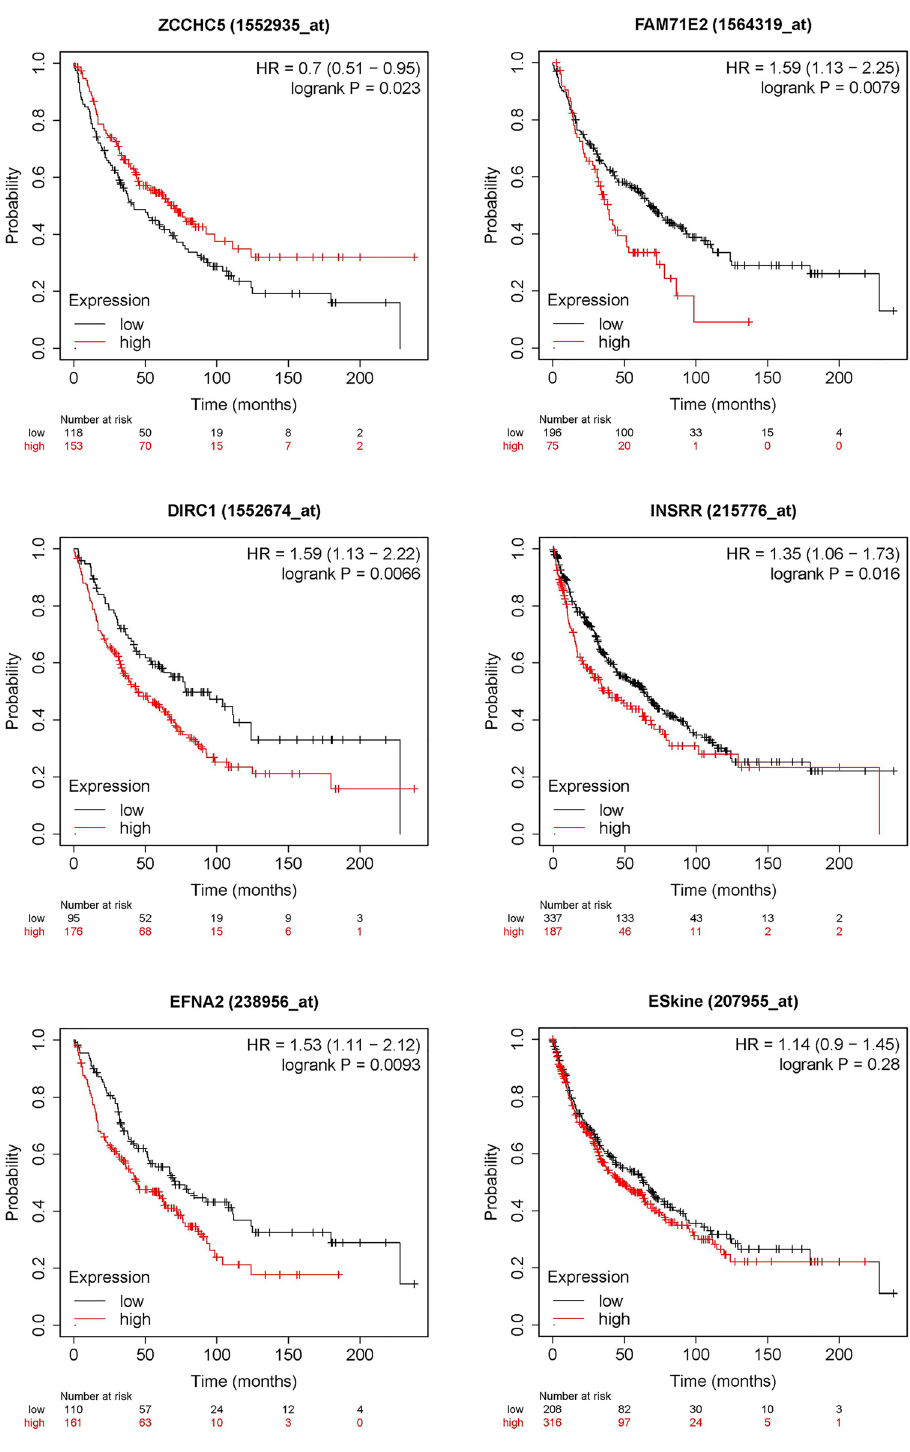
Figure 4. The analysis of overall survival-related